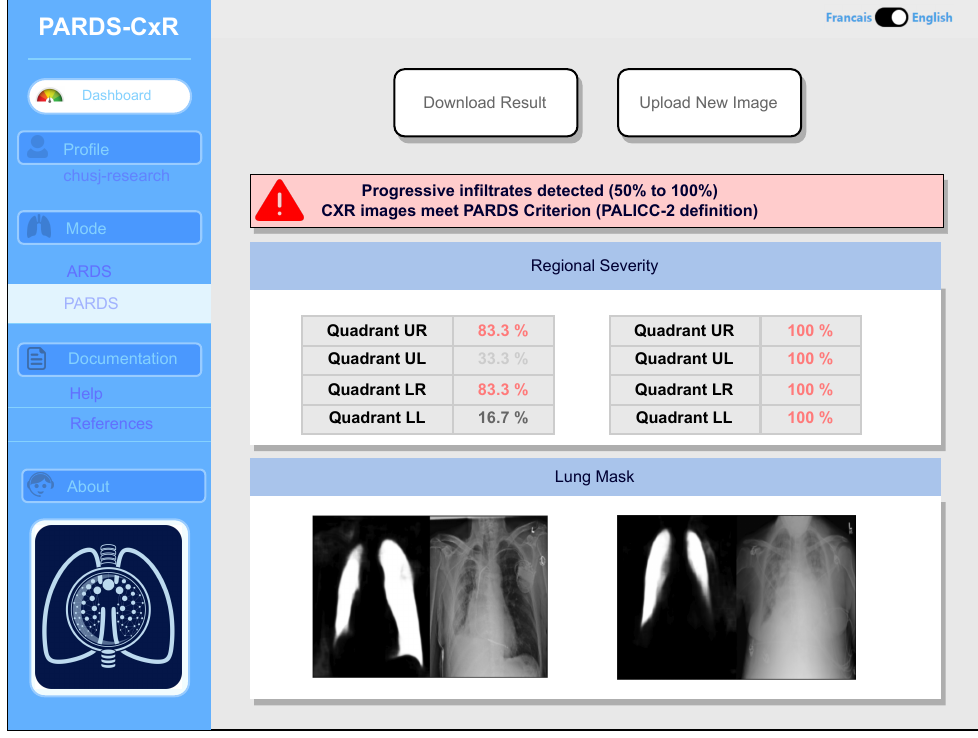
Figure 8. PARDS-CxR interface in image comparison mode. The platform can analyze two CXR images to detect ARDS progression based on the PALICC-2